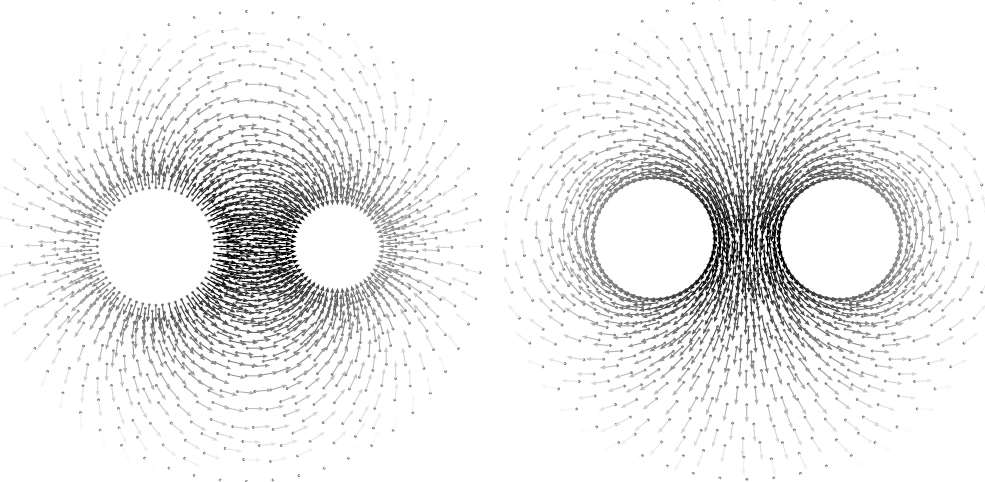
Figure 6. Numerical solutions for electrical ( left ) and magnetic fields ( right